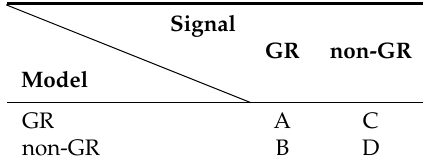
Table 1. Studies considered in this work. In cases A and B, GR signals are injected and then attempted to be extracted with a GR and a non-GR model, respectively. Case A aims to estimate the accuracy to which accretion disk model parameters can be measured, while case B aims to determine how well a non-GR deviation can be constrained. Conversely, in cases C and D, non-GR signals are injected and then extracted with a GR model and a non-GR model, respectively. Case C aims to estimate the systematic uncertainties introduced in the extraction of accretion disk model parameters due to the a priori assumption that GR is correct, while D aims to determine whether GR deviations can be detected if they are present in the